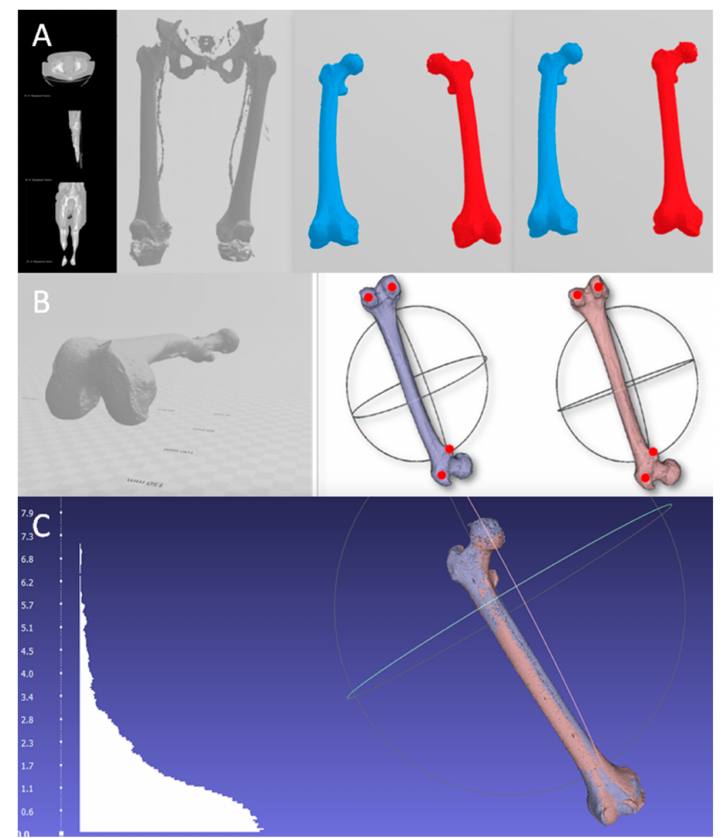
Figure 1. Steps to obtain the model and its alignment. ( A ) The 3D biomodel is obtained from the tomography, from which the right (blue) and left (red) femur are isolated to subsequently perform the mirror image of the left side. ( B ) Alignment with the horizontal of the femur and marking the reference points for subsequent alignment. To establish a common horizontal plane to all the points that will be used during the manual alignment, the table top method was used [16]. ( C ) Result after superimposing both femurs and the histogram with the di ff erences of the anatomical points